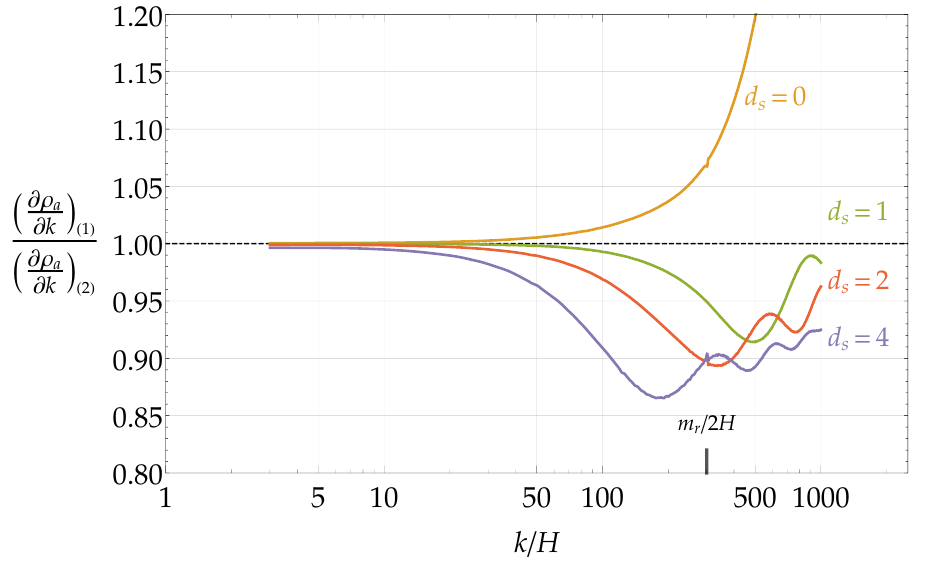
Figure 21 . The spectrum calculated with method (1), described in the text, for di(cid:11)erent screening distances d s , normalised to the spectrum calculated with method